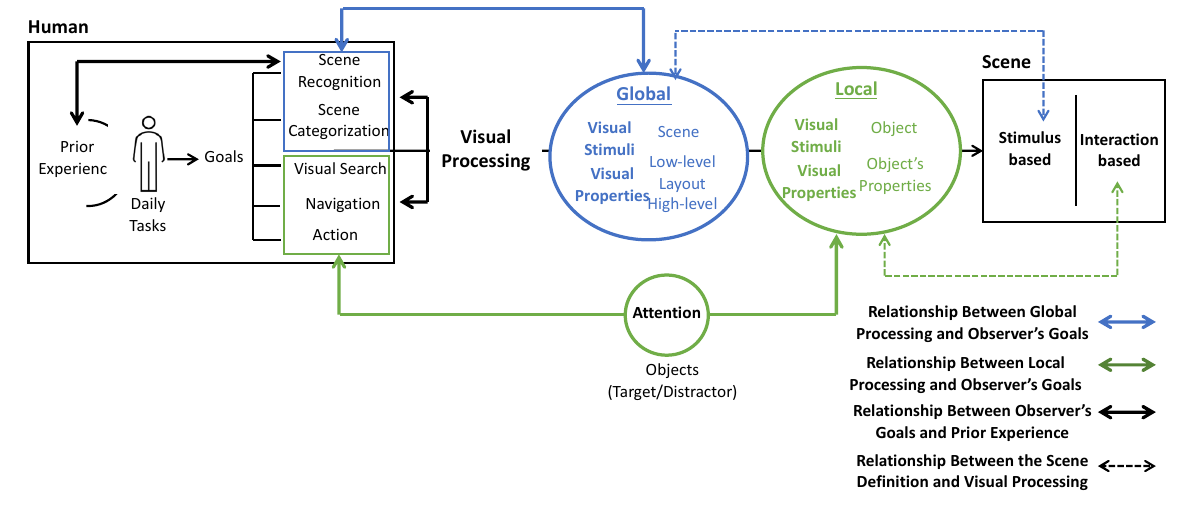
Figure 8. A visual processing framework.